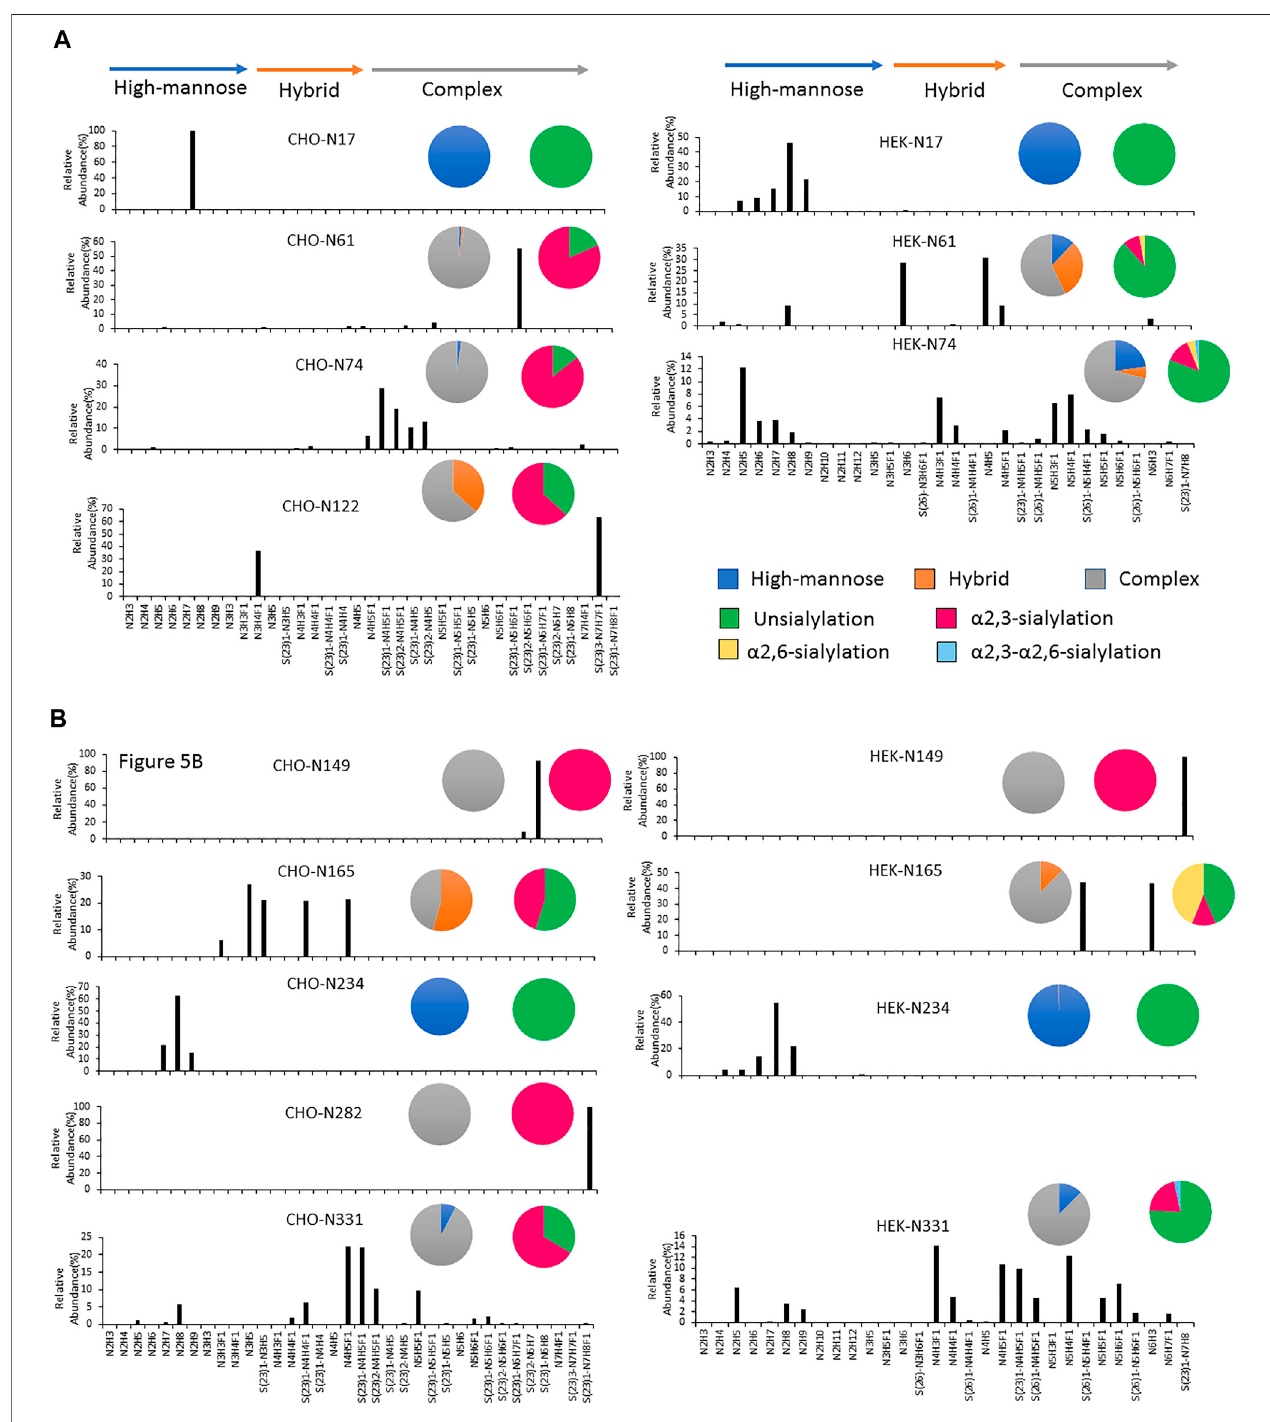
FIGURE5| Thesite-speci fi cmajorN-glycandistributionandcomparisonofSARS-COV-2spikefromCHOandHEKcells,respectively.Thepiechartssummarized the N-glycan type distribution and the sialylation linkage information identi fi ed at each site. The key is shown in (A) . Glycosite comparisons are shown as follows: (A) Glycosites N17, N61, N74 and N122, (B) N149, N165, N234, N282 and N331, (C) N343, N603, N616, N657 and N709, (D) N717, N801, N1074, N1098 and N1134, and (E) N1173 and N1194. The complete lists of N-glycans at each site were presented in Supplementary Table S5 .